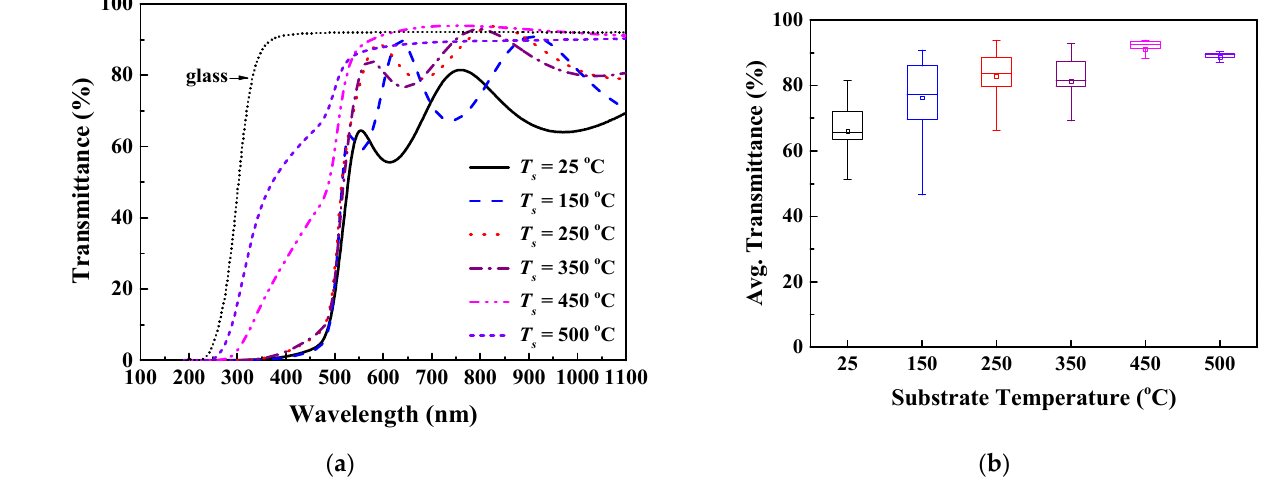
Figure 3. Optical transmittance spectral results for CdS thin films fabricated at various substrate temperatures: ( a ) transmittance spectrum and ( b ) average transmittance distribution.